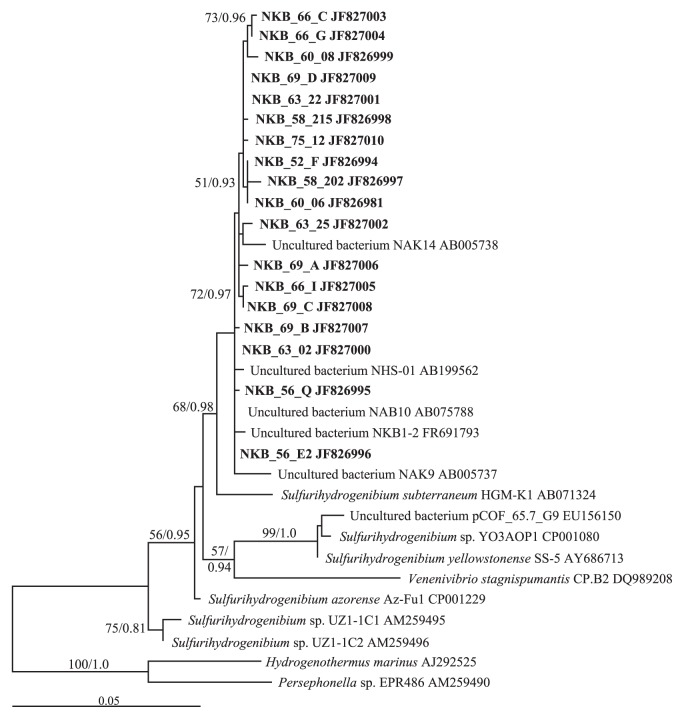
Maximum likelihood phylogenetic tree of Sulfurihydrogenibium spp. based on partial 16S rRNA gene sequences. Clones from this study are in bold. Genbank accession numbers follow each sequence name. Bootstrap support >50 for ML and Bayesian posterior probabilities >0.7 are given at the nodes supported by both measures. Hydrogenothermus marinus and Persephonella sp. EPR486 were used as outgroup taxa.